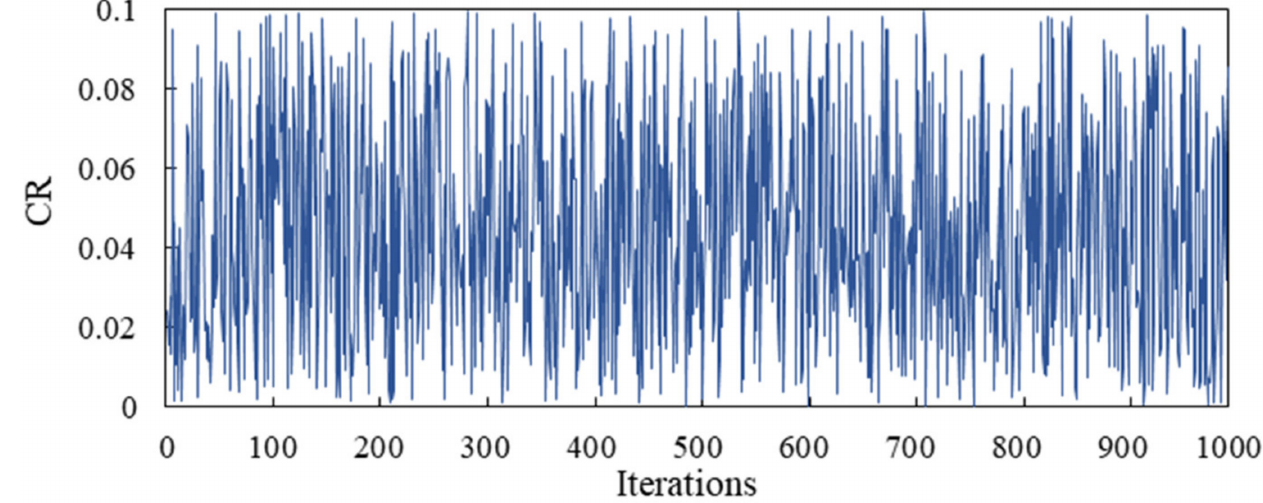
Figure 3. CR calculation results of MCAHP.